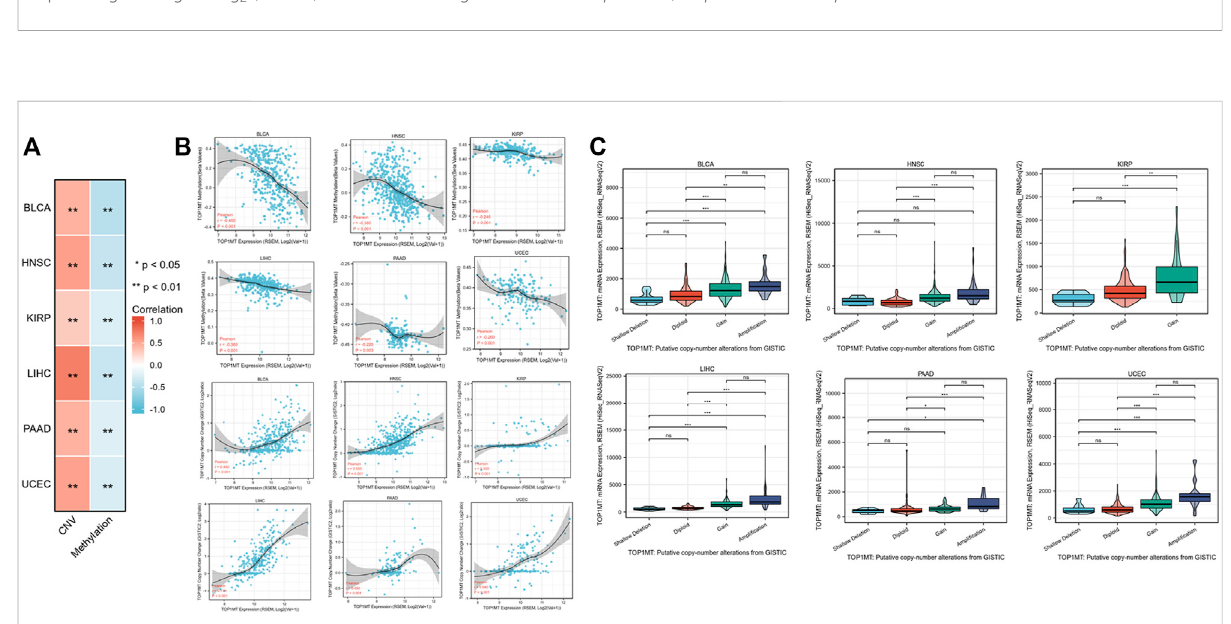
FIGURE 5 Correlationbetween TOP1MT expression,primarypathologicalstages,andprognosis. (A) Relationshipbetween TOP1MT mRNAexpressionand different pathological stages in different cancer patients from TCGA; (B) Kaplan-Meier survival curves of TOP1MT mRNA expression in different pathological stages. Log 2 (TPM+1) is used for the logarithmic scale. p p < 0.05, pp p < 0.01 and pp p < 0.001.